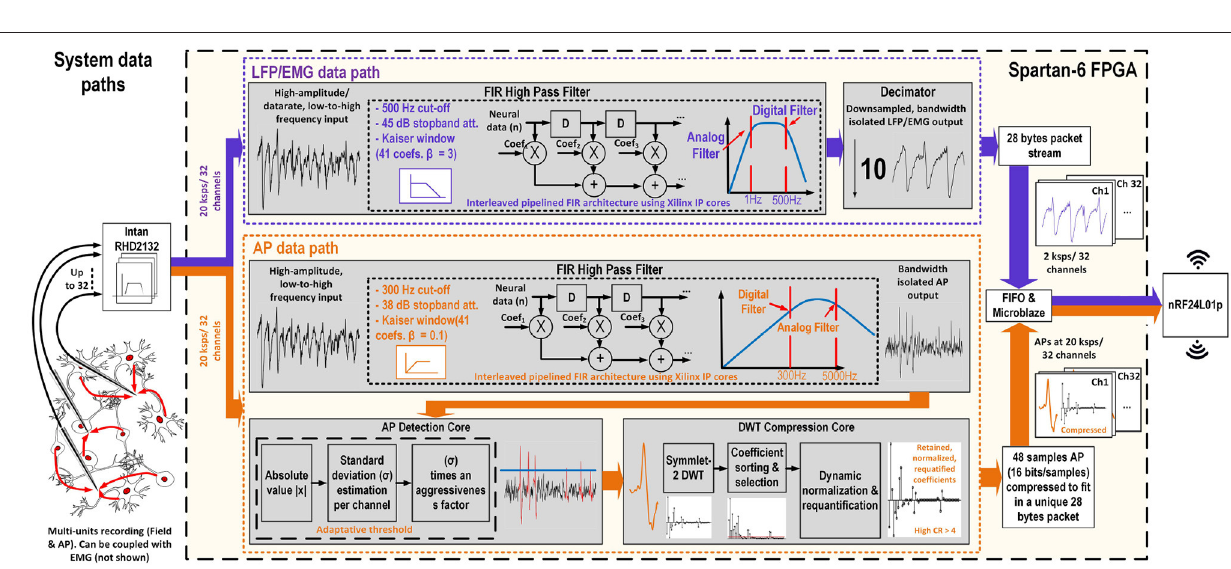
data flow for the AP and the LFP/EMG data is illustrated in Figure 3